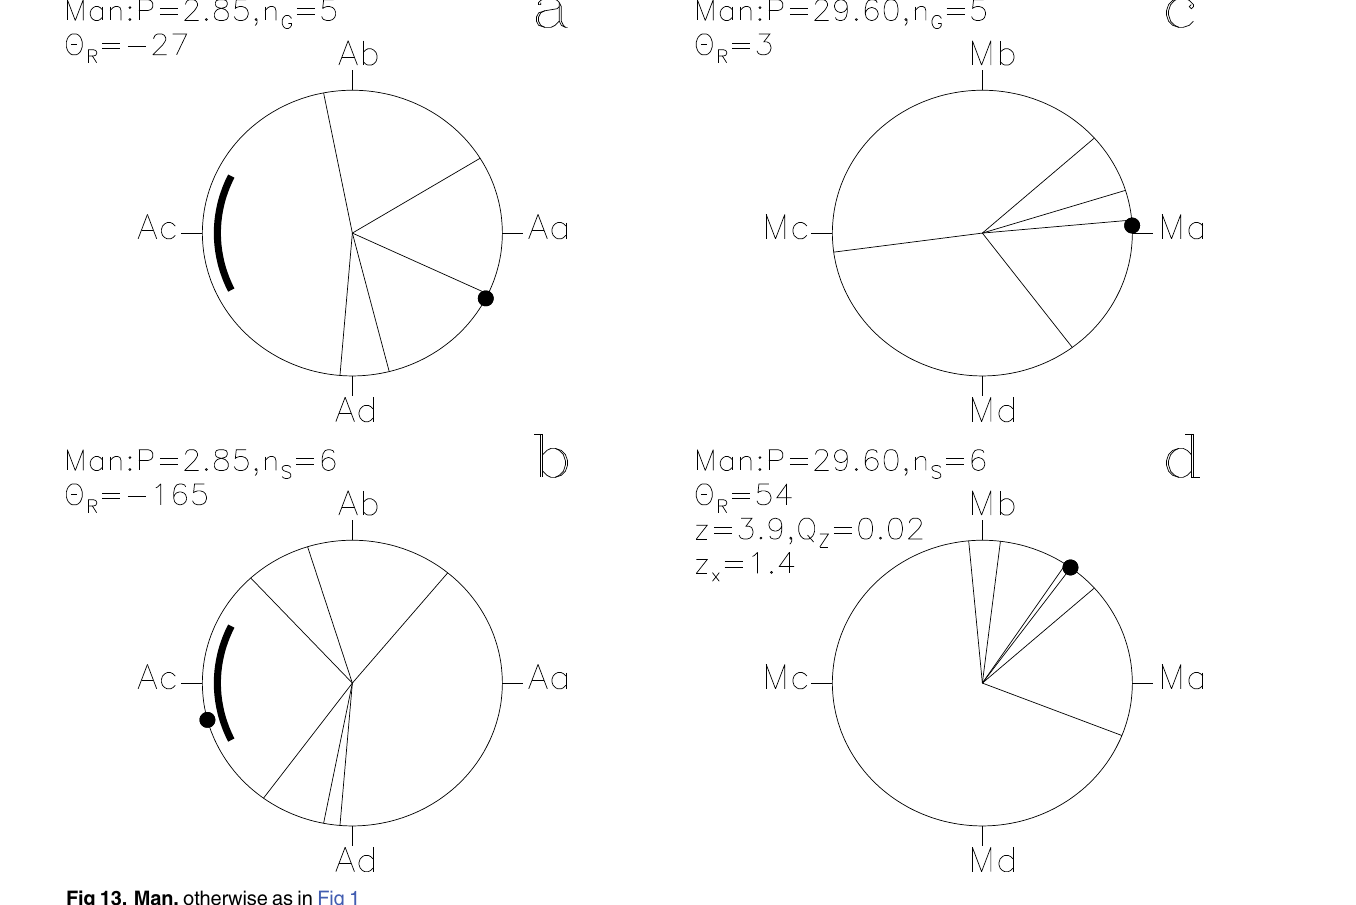
Fig 13. Man. otherwise as in Fig